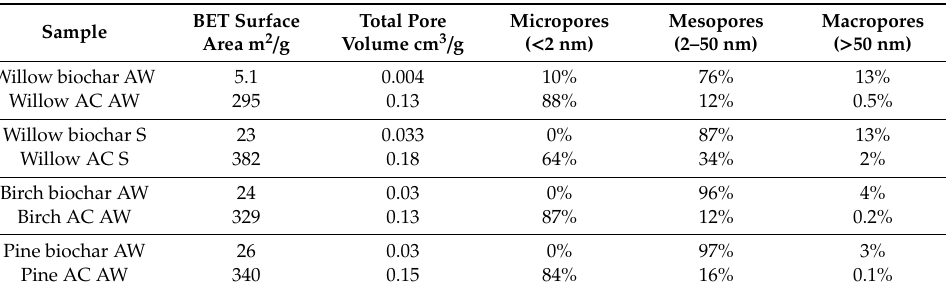
Table 4. Surface area and porosity results of the acid-washed and sulfonated biochars and